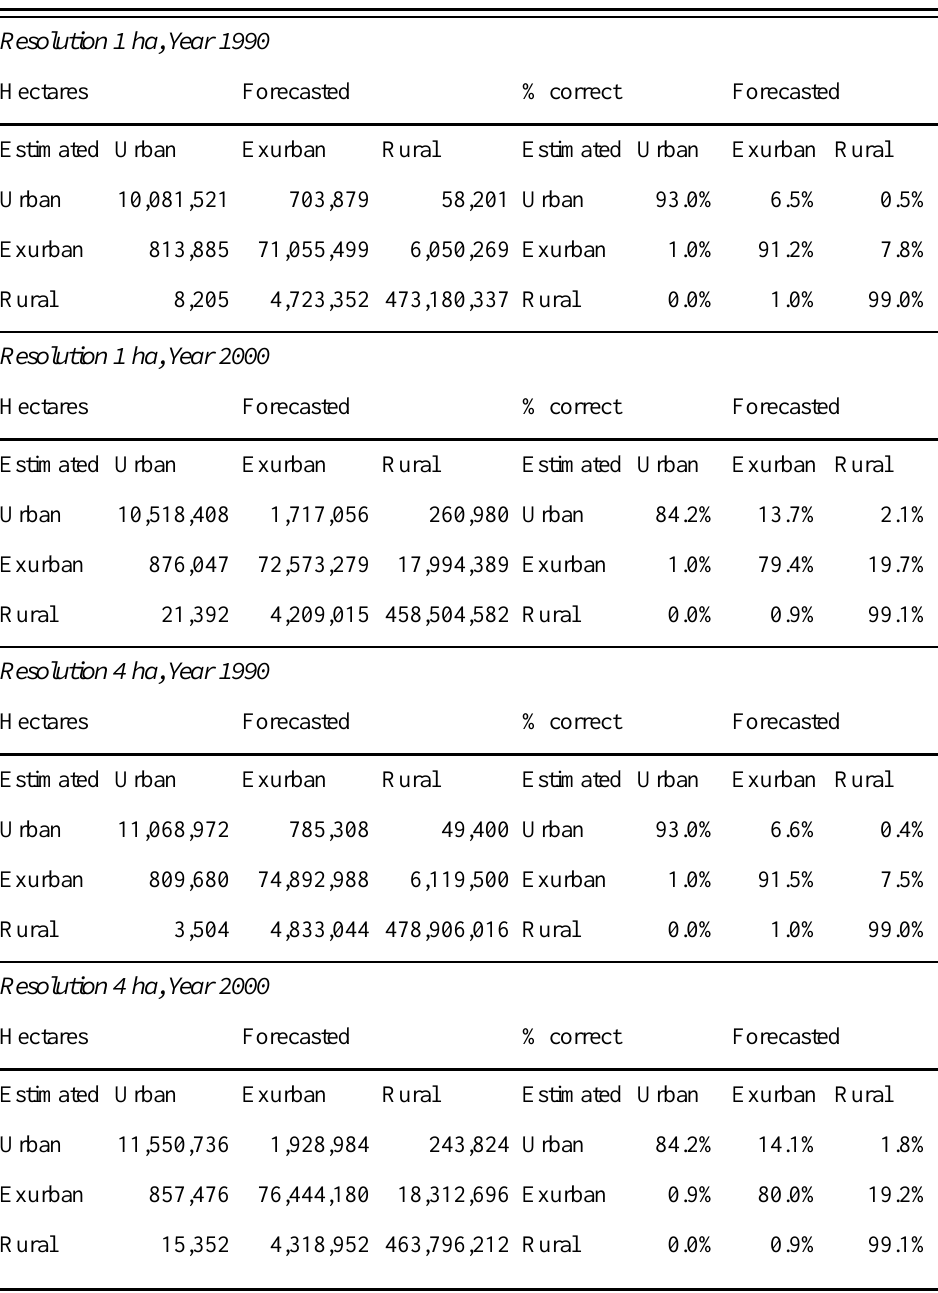
Table 2. The results of the test of the SERGoM model comparing estimated areas for urban/suburban, exurban, and rural housing density classes for 1990 and 2000 against forecasted